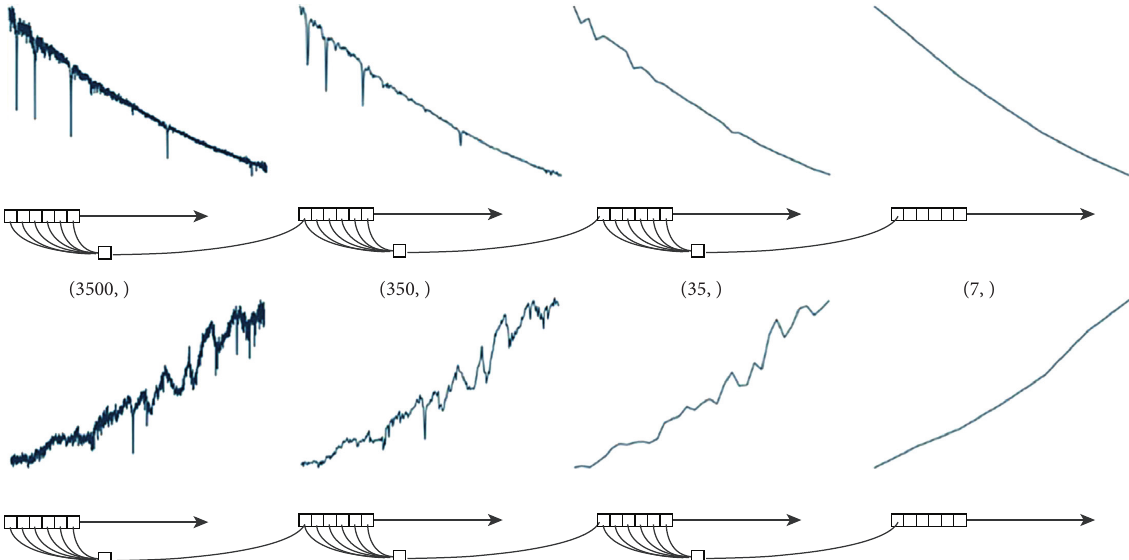
Figure 5: The procedure of average pooling for extracting general features of spectral data.1D convolutional neural network for spectral classification.